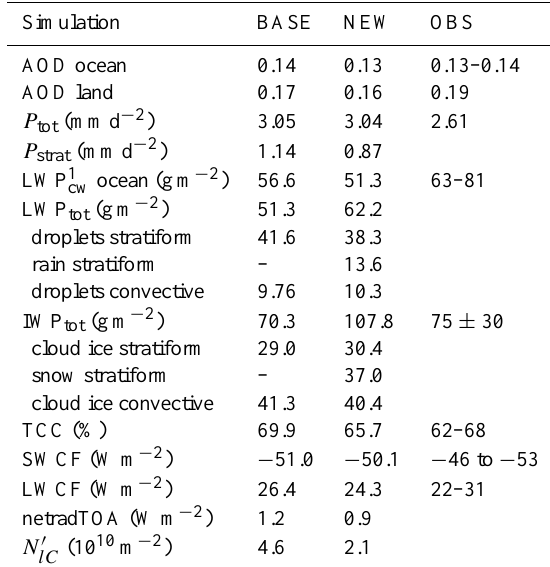
Table 2. Global annual mean model results and observations: Aerosol optical depth (AOD) estimates based on MODIS (Remer et al., 2008), surface precipitation ( P tot ) based on GPCPv2 (Adler et al., 2003), liquid water path (LWP) over ocean based on SSM/I (Greenwald et al., 1993; Weng and Grody, 1994), ice water path (IWP) based on CloudSat (Austin et al., 2009), total cloud cover (TCC) based on ISCCP (Rossow and Schiffer, 1999) and surface observations (Warren et al., 1986, 1988), short wave cloud forcing (SWCF) and longwave cloud forcing (LWCF) ranges based on vari- ous satellite products compiled by Loeb et al. (2009) and for LWCF also on TOVS retrievals Susskind et al. (1997); Scott et al. (1999) (ρN 0 )dz is the column- cited from Lohmann et al. (2007). N 0 = R z lC l integrated in-cloud droplet